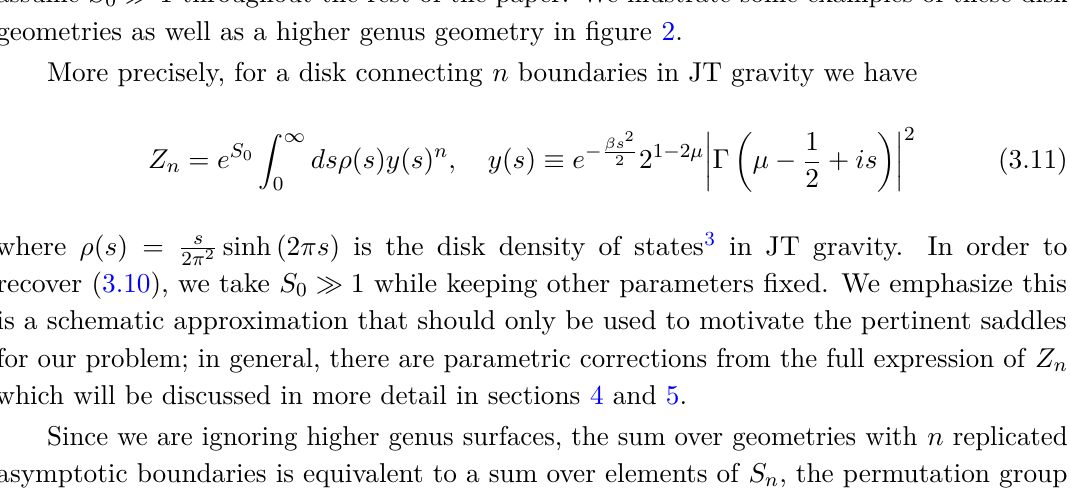
Figure 2 . Boundary conditions and some possible classical geometries that contribute to Tr Index lines that run along EOW branes are not shown for visual clarity. Left: the partially transposed boundary conditions from figure 1 with brane flavor indices contracted. Center left and right: the geometries consist of disjoint unions of disks in non-crossing or crossing configurations. Right: the geometry has a single handle and will be suppressed by a factor of e − 2 S 0 relative to the first